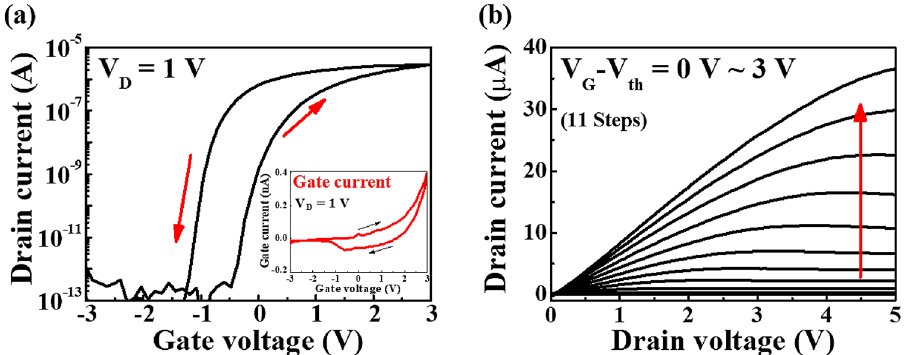
Figure 4. Electrical properties of the chitosan electrolyte-Ta 2 O 5 hybrid EDLT. ( a ) The transfer characteristics, where V G was swept from – 3 to 3 V in the dual-sweep mode at V D = 1 V. The inset shows the gate leakage current. ( b ) The output characteristics (I D –V D ) measured by V G –V th from 0 to 3 V in 0.3 V steps.